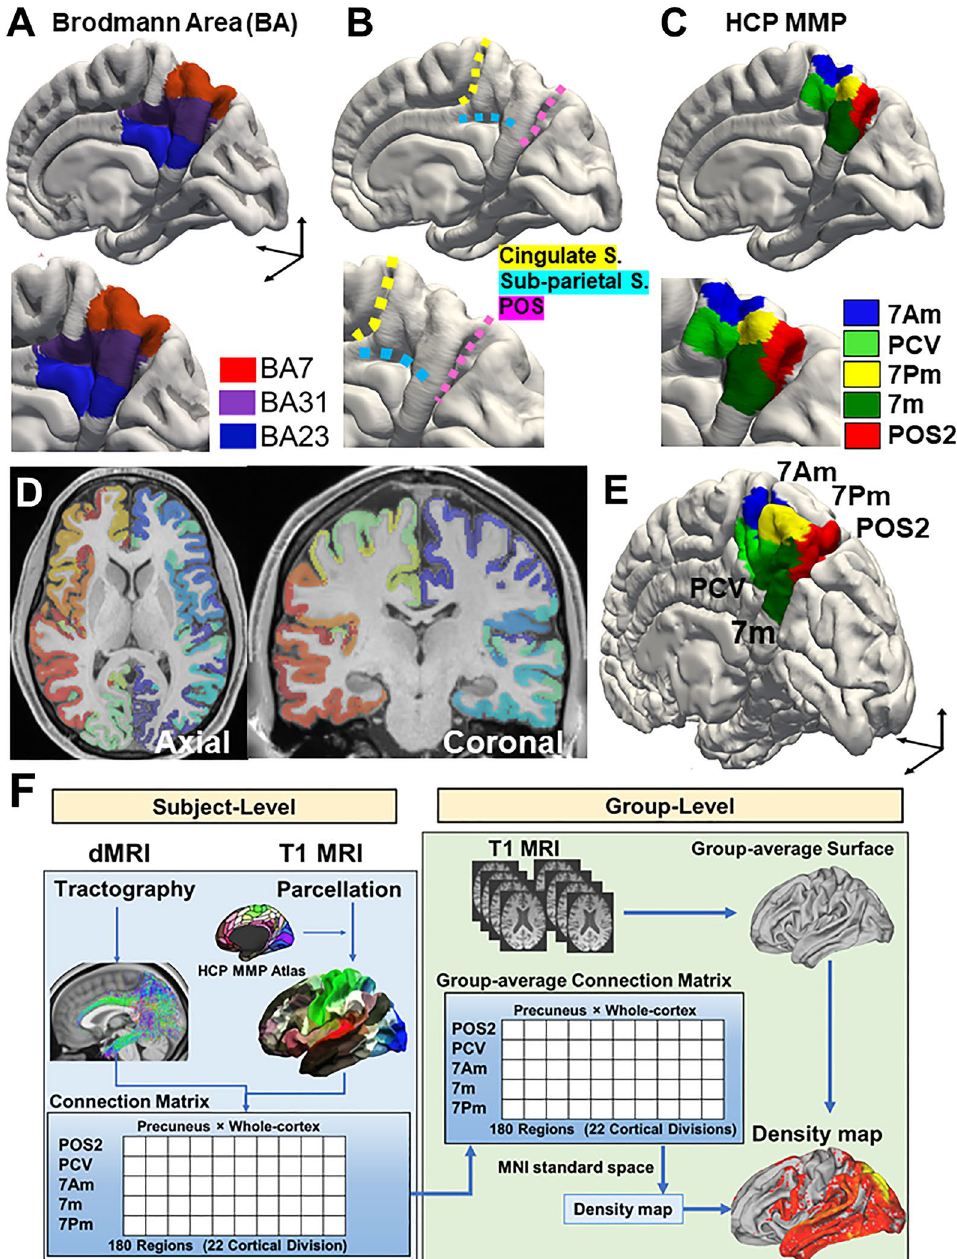
Figure 1. Neuroanatomy and parcellation of precuneus. ( A ) The territory of Brodmann areas 7, 23, and 31 (in the FreeSurfer atlas) were rendered on the template brain (Pial surface). ( B ) The precuneus is bordered by the marginal branch of the cingulate sulcus (Cingulate S.) anteriorly, by the sub-parietal sulcus (Sub-parietal S.) inferiorly, and by the parieto-occipital sulcus (POS) posteriorly. ( C ) Parcellation of precuneus by HCP MMP atlas in the template brain. ( D ) Representative parcellation of single subject’s brain images (axial and coronal) by HCP MMP atlas (Subject ID: HCP #102614). ( E ) Representative parcellation of precuneus by HCP MMP atlas in a single subject’s brain image (Subject ID: HCP #103414). ( F ) Flow chart showing the workflow to produce density map of streamline endpoint by probabilistic tractography. At the subject-level, diffusion MRI (dMRI) data were analyzed to produce a structural connection matrix by probabilistic tractography. T1 MRI data were analyzed to annotate labels in the HCP-MMP atlas and to produce a group average white surface brain. After producing a group-level structural connection matrix based on the HCP MMP atlas, the endpoint density map was rendered on the group-average white matter surface in MNI standard space. Details of this process are shown in Supplementary Fig.